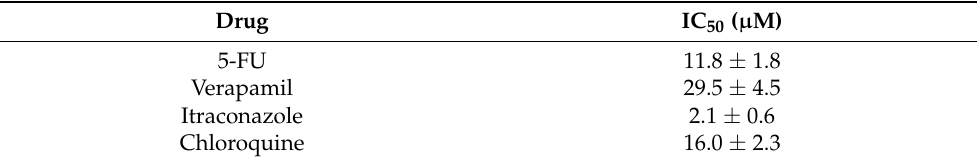
Table 2. IC 50 values of 5-FU, verapamil, itraconazole and chloroquine in MCF-7